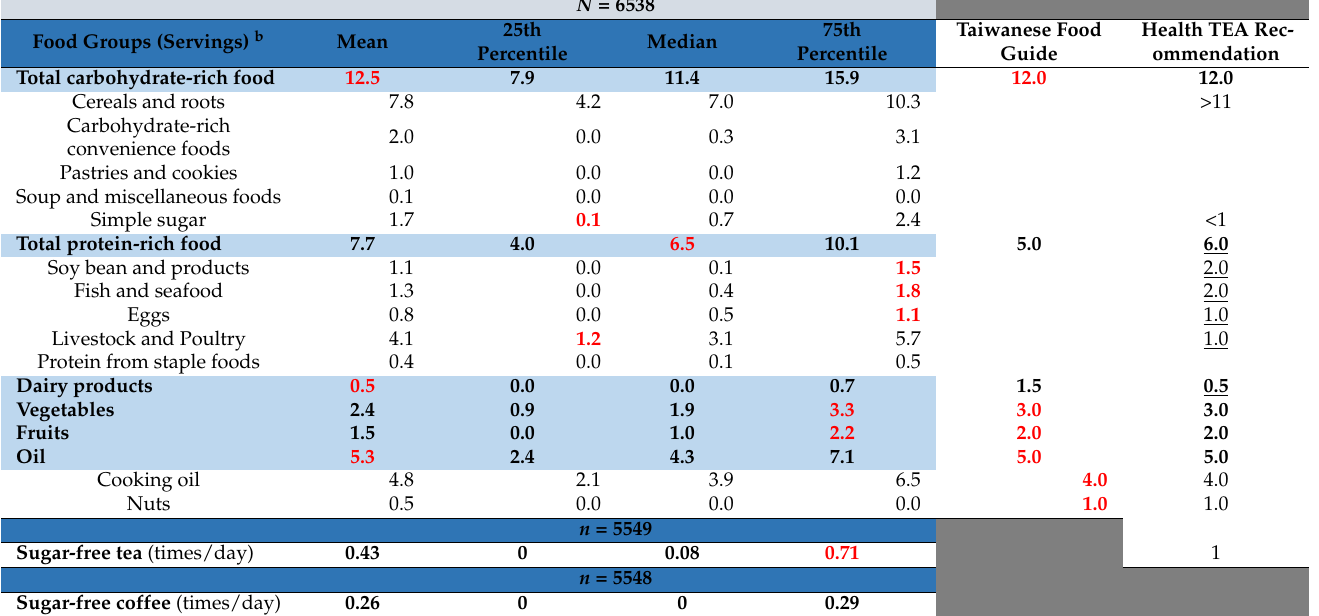
Table 3. Taiwanese mean intake, percentile intake, and recommendation serving numbers for the 6 food groups a . N =